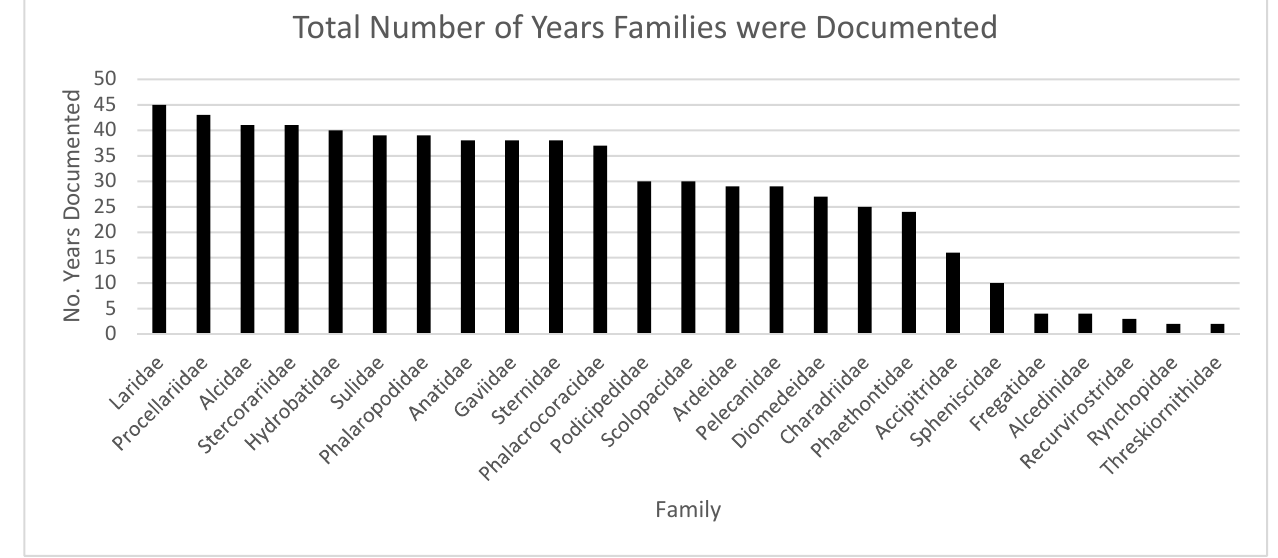
Figure 6. The total number of years each family was documented. Laridae and Procellariidae were documented for the most years (45 and 43 years, respectively). Rynchopidae and Threskiornithidae were documented the least, 2 years (common name equivalents can be found in Table 1).